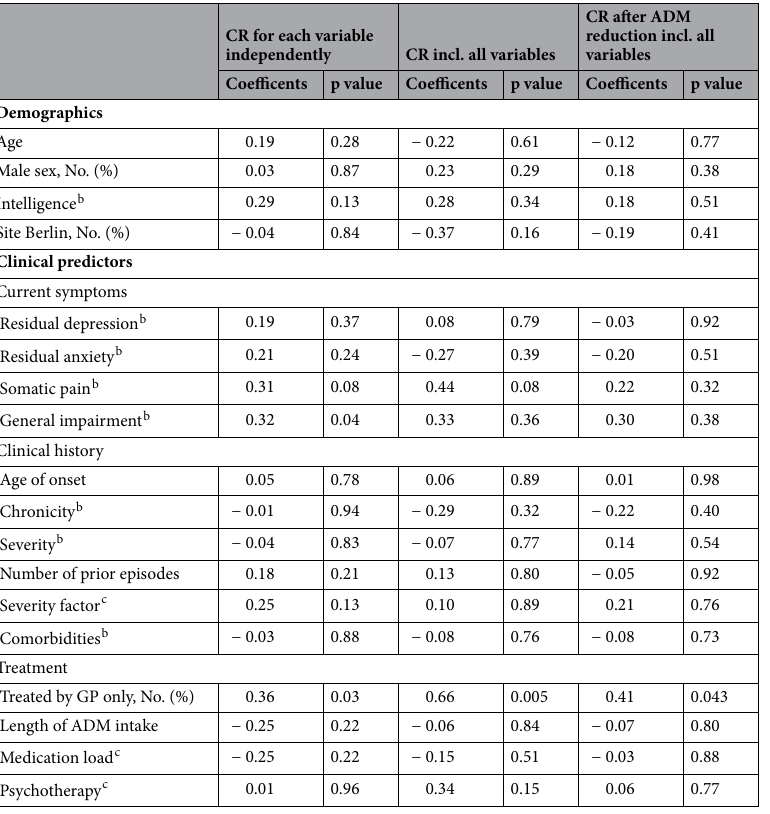
a Table 2. Intention-to-treat analyses. Unless stated otherwise, mean (SD) are shown; intelligence: Mehrfachwahl Wortschatz Test 38 ; residual depression: Inventory of Depressive Symptomatology- Clinician Rated 39 ; residual anxiety: screening generalised anxiety disorder (GAD-7 40 ); somatic pain: